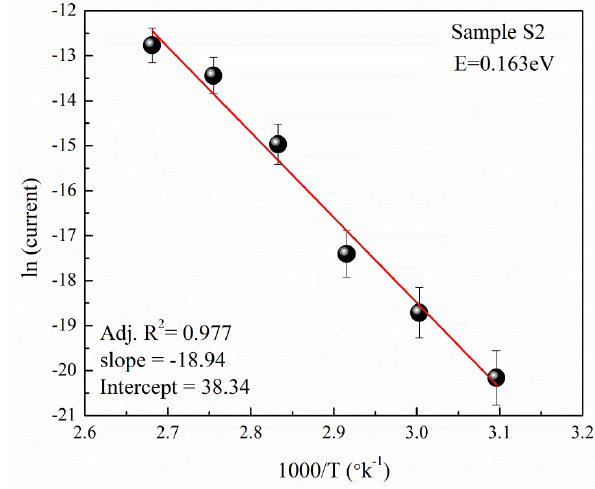
Figure 7: ln (I) versus 1000/T for S2(10 vol.% choloroform) nanocom- posite